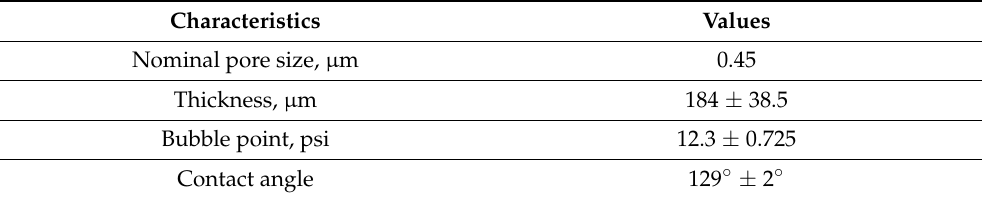
Table 2. Membrane specifications as provided by the